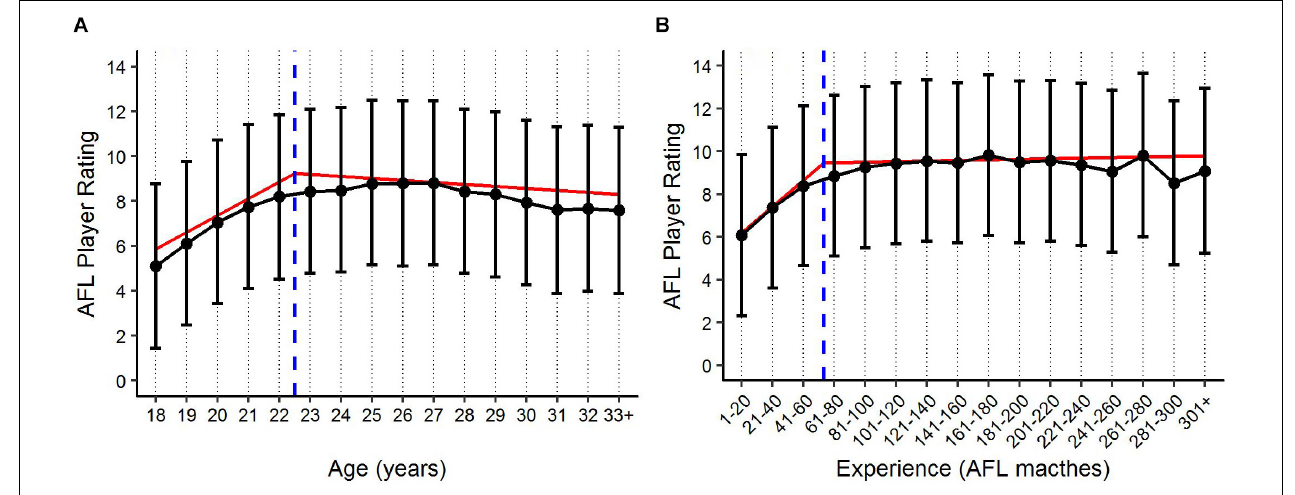
FIGURE 5 | Benchmark levels of AFL Player Ratings ( ± 90% PI) by (A) age and (B) experience, based on the fixed effects estimates. Blue x -axis intercept lines represent the level at which the breakpoint in performance occurs for both age and experience, respectively. Red regression lines represent the multiple linear fits of the segmented models.